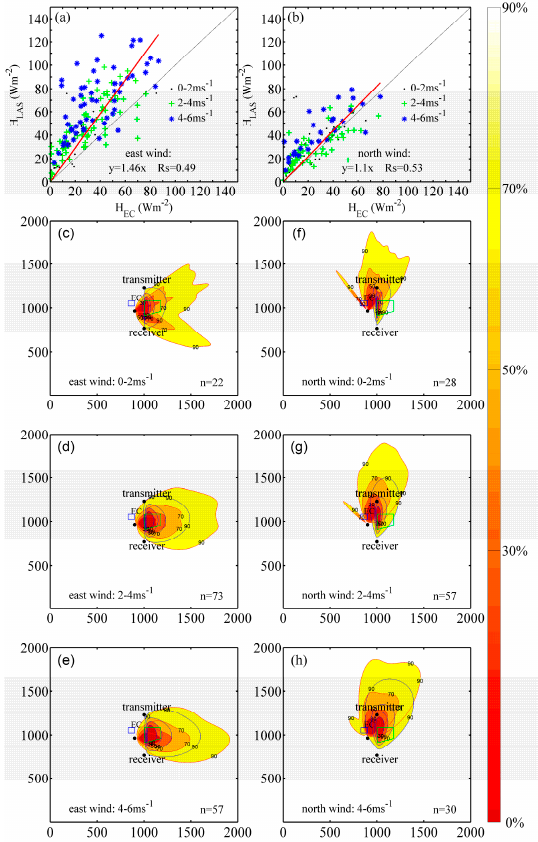
Figure 9. Relationship between LAS-derived and EC-derived sensible heat fluxes under ( a ) east wind and ( b ) north wind conditions. The different wind speed was plotted in black point (0–2 m s − 1 ), green plus sign (2–4 m s − 1 ) and blue asterisk (4–6 m s − 1 ). The slopes and determination coefficients were also shown in the picture. The regression lines were plotted in red. The corresponding average footprints when east wind was 0–2 m s − 1 ( c ), 2–4 m s − 1 ( d ) and 4–6 m s − 1 ( e ). The corresponding average footprints when north wind was 0–2 m s − 1 ( f ), 2–4 m s − 1 ( g ) and 4–6 m s − 1 ( h ). The blue rectangle represents the grove, and the green trapezoid represents the mulberry seedling field. The numbers (n) of data points are also given in the figure.